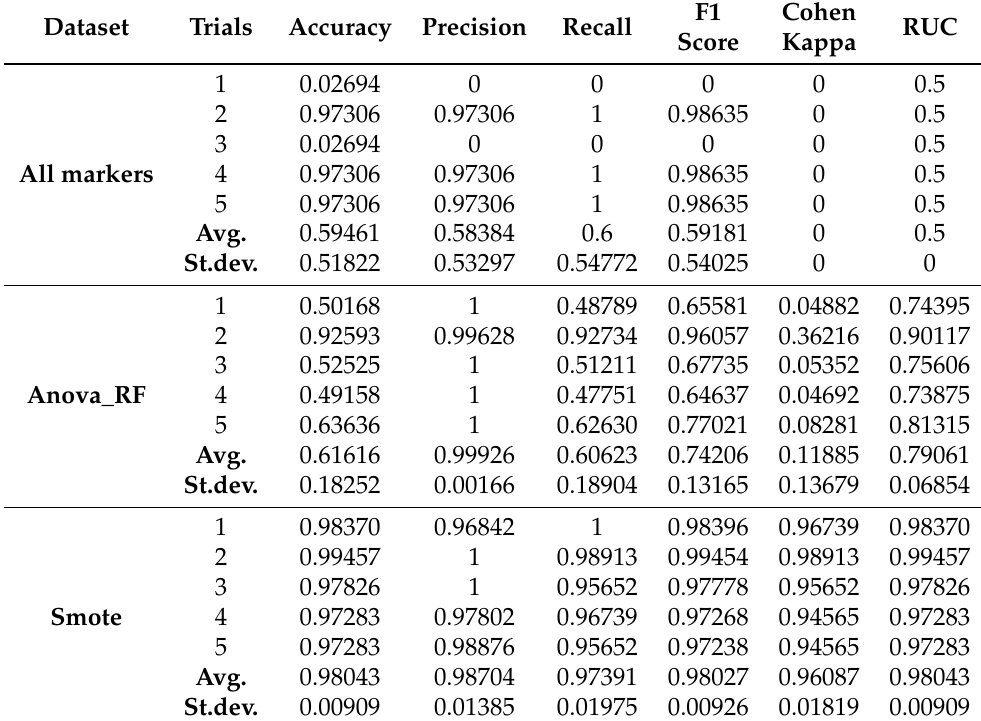
Table A1. Results of deep learning model on 27K